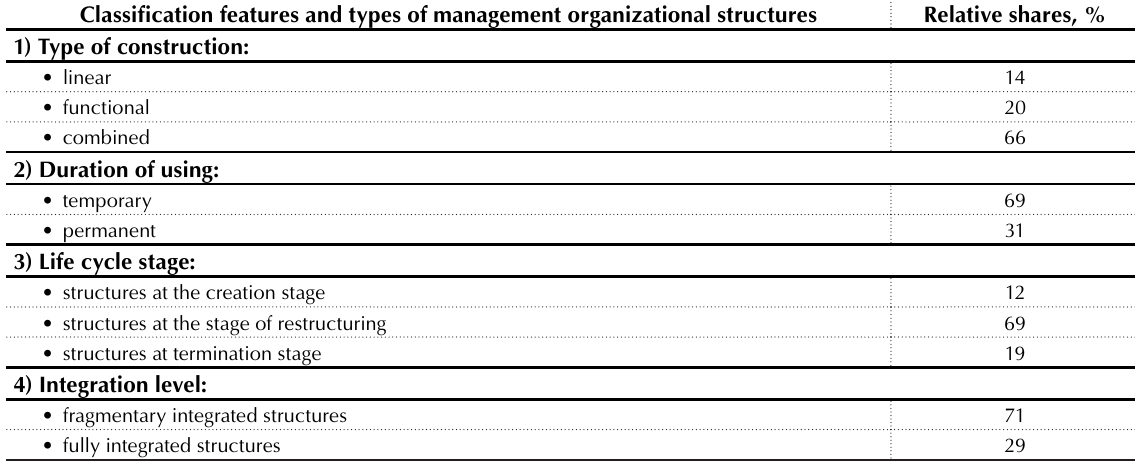
Table 2. Types of the organizational structures in the BMS for January 1, 2018 Classification features and types of management organizational structures